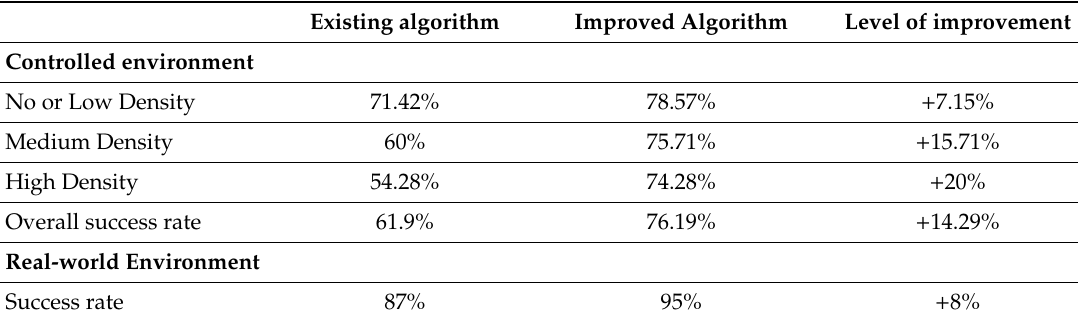
Table 7. Comparison of overall success rates of both